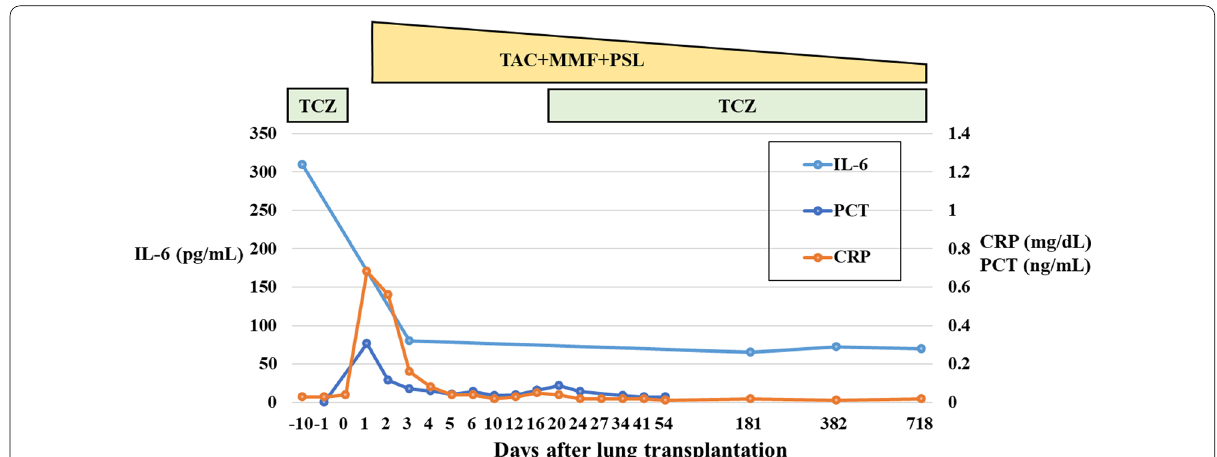
Fig. 3 Postoperative course after lung transplantation. Tapering of triple immunosuppression (tacrolimus [TAC], mycophenolate mofetil [MMF], and prednisolone [PSL]) and sustained treatment with tocilizumab (TCZ) in an idiopathic multicentric Castleman disease transplant recipient. The interleukin-6 (IL-6) levels are maintained at 60–80 pg/mL, and the C-reactive protein (CRP) and procalcitonin (PCT) levels are trending towards normal with no allograft